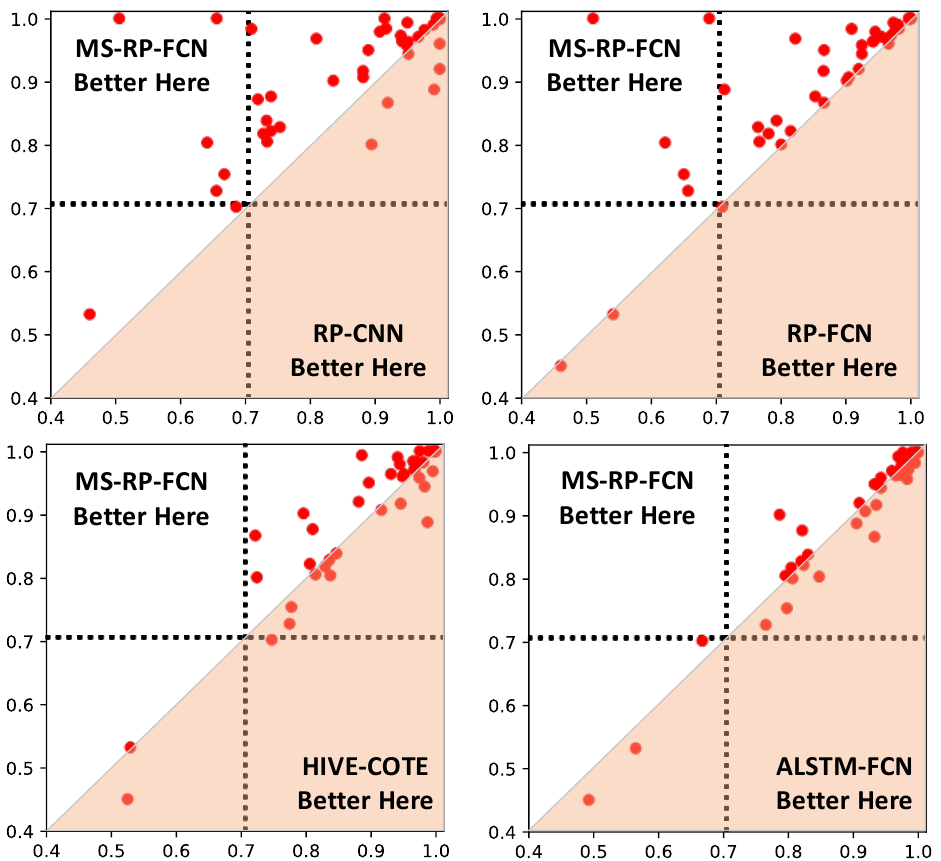
Figure 9. Pairwise comparison of classification performances between MS-RP-FCN and the